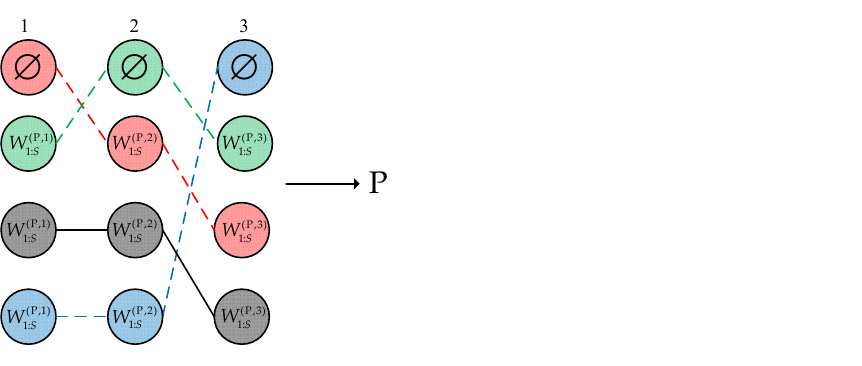
Figure 2. Illustration of the second step. Partitions are formed by sequentially processing the set ( P, i ) W . In the i -th column, differently colored W 1:4 the two-step greedy partitioning